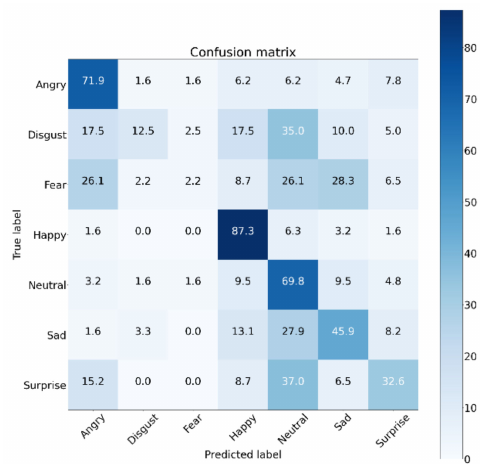
Figure 9. Confusion matrix of DGNNC3D-GRU for the AFEW